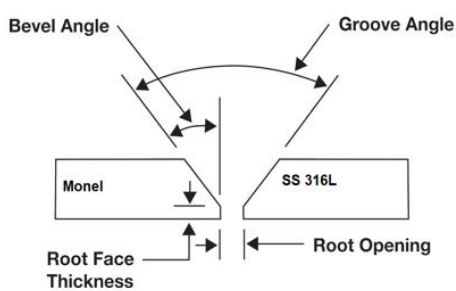
Figure 1. Weld groove typical section.